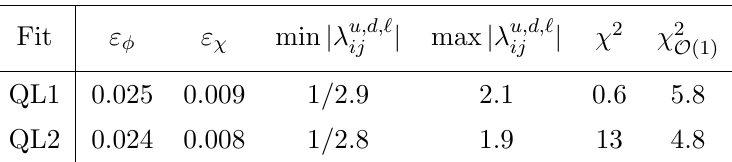
Table 4 . Best (cid:12)ts in the quark and charged lepton sector including the CKM phase.